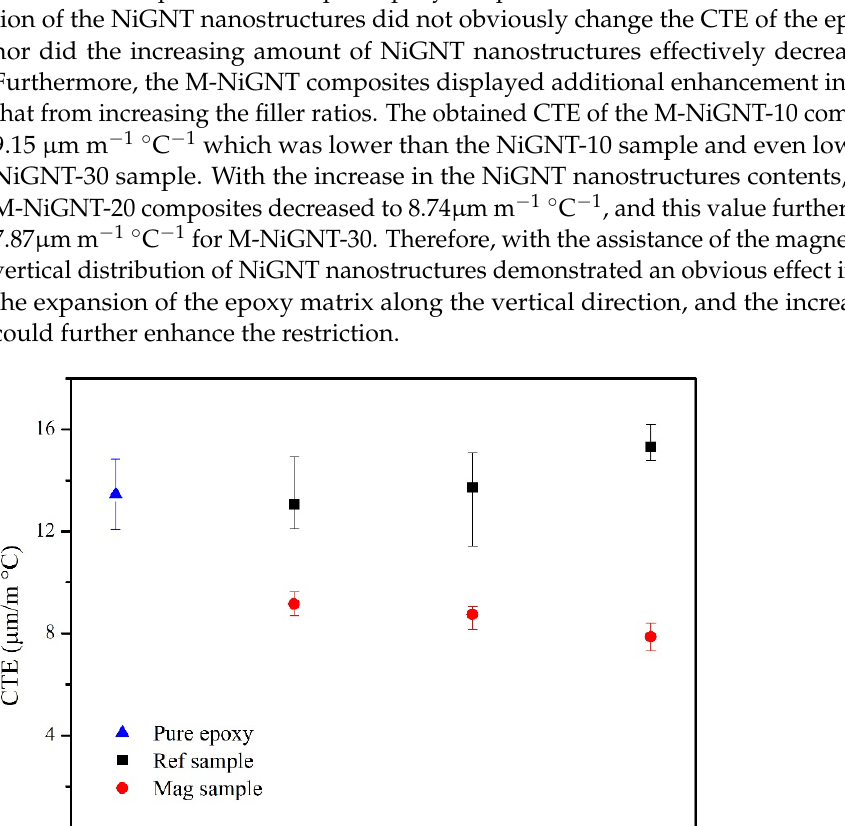
Figure 9. Thermal diffusivity ( a ) and thermal conductivity ( b ) of pure epoxy and the NiGNT–epoxy composites with different ratios.